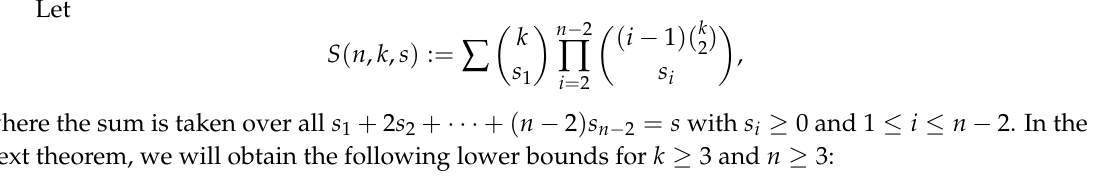
Theorem 5 Theorem